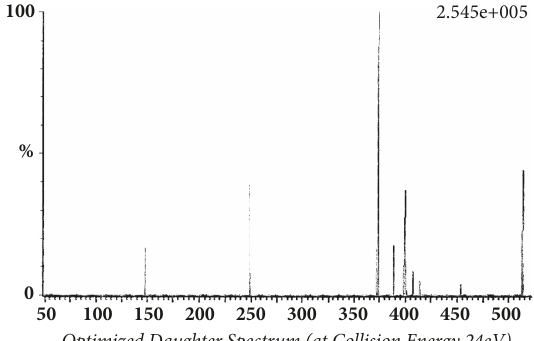
Figure 2: Transition of glibenclamide sodium adduct to daughter fragment (m/z 516.11 > 391).